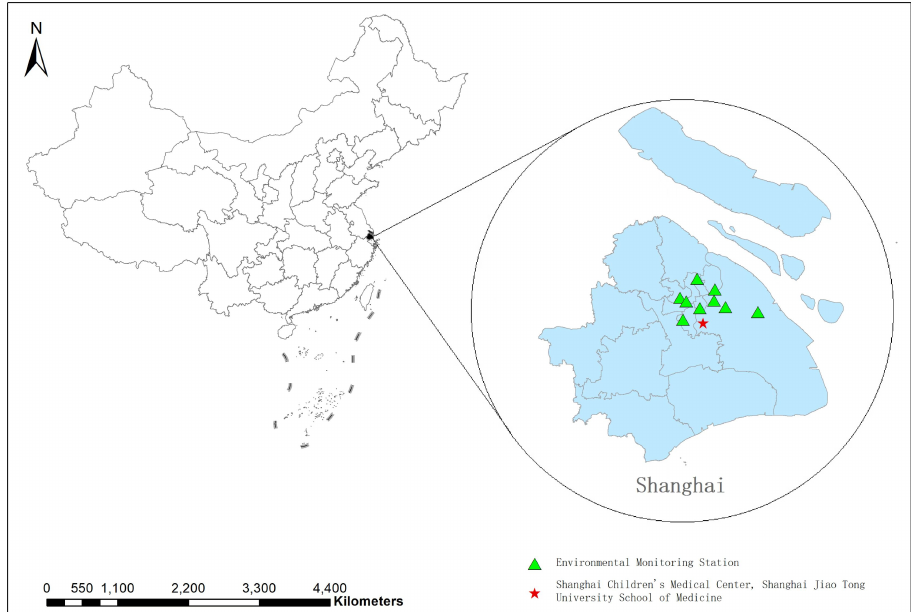
Figure 2. Location of environmental monitoring station and Shanghai Children’s Medical Center, Shanghai Jiao Tong University School of Medicine in